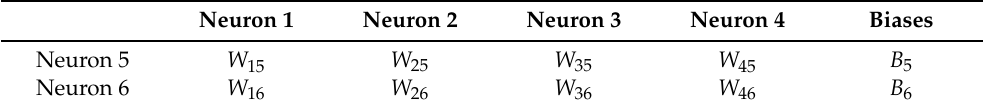
Table A2. Corresponding weights and biases between hidden layer 1 and hidden layer